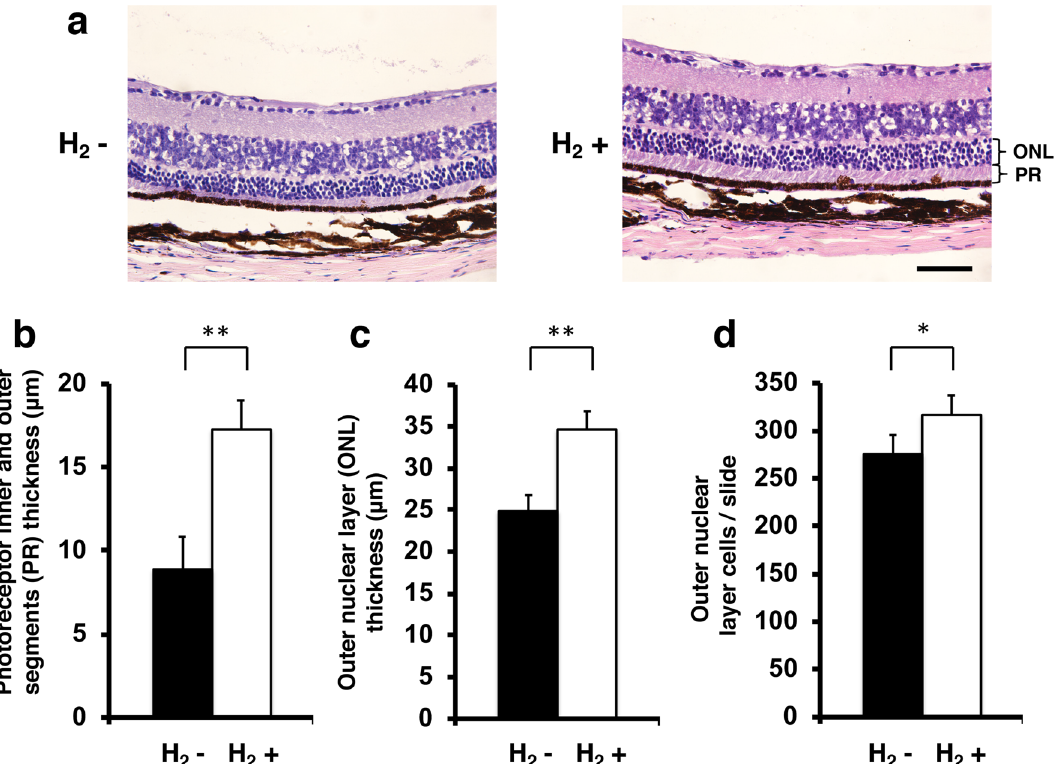
Figure 4. Thickness of photoreceptor inner and outer segments and outer nuclear layer and number of outer nuclear layer cells. ( a ) Images of representative slices from the control group (n = 4) and H 2 group (n = 4). Photoreceptor inner and outer segments (PR) thickness and outer nuclear layer (ONL) are shown. ( b ) Photoreceptor inner and outer segments thickness with/without H 2 water. Thickness was significantly greater with H 2 water than without H 2 water (p < 0.01). ( c ) Outer nuclear layer (ONL) thickness with/without H 2 water. Thickness was significantly greater with